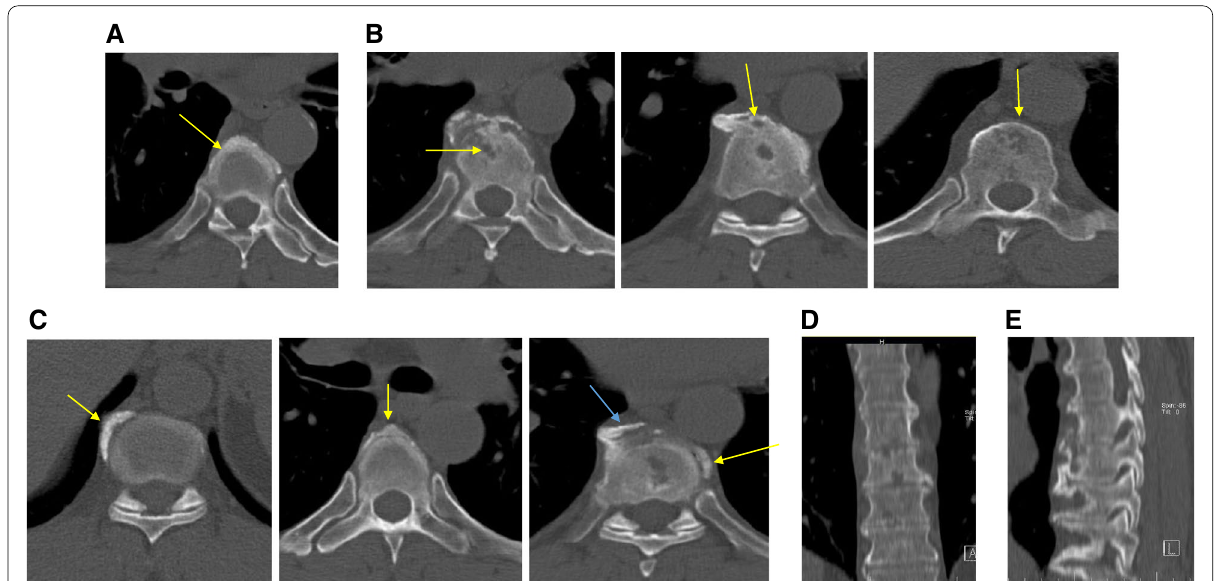
Fig. 5 Sagittal and coronal CT of thoracic spines. Coronal view shows markedly cortical thickening (hyperostosis) of thoracic vertebrae ( A ) and multiple cortical erosions ( B ). Severely thickened ossification of anterolateral spinal ligament along with large osteophytes without disk space involvement suggestive of DISH ( C ). AP view showing relative symmetrical non-marginal syndesmophytes ( D ). Sagittal view shows thick flowing osteophytes consistent with DISH ( E ). CT, computed tomography; AP, anteroposterior; DISH, diffuse idiopathic skeletal hyperostosis. All radiographic images were screenshotted from the compact discs.